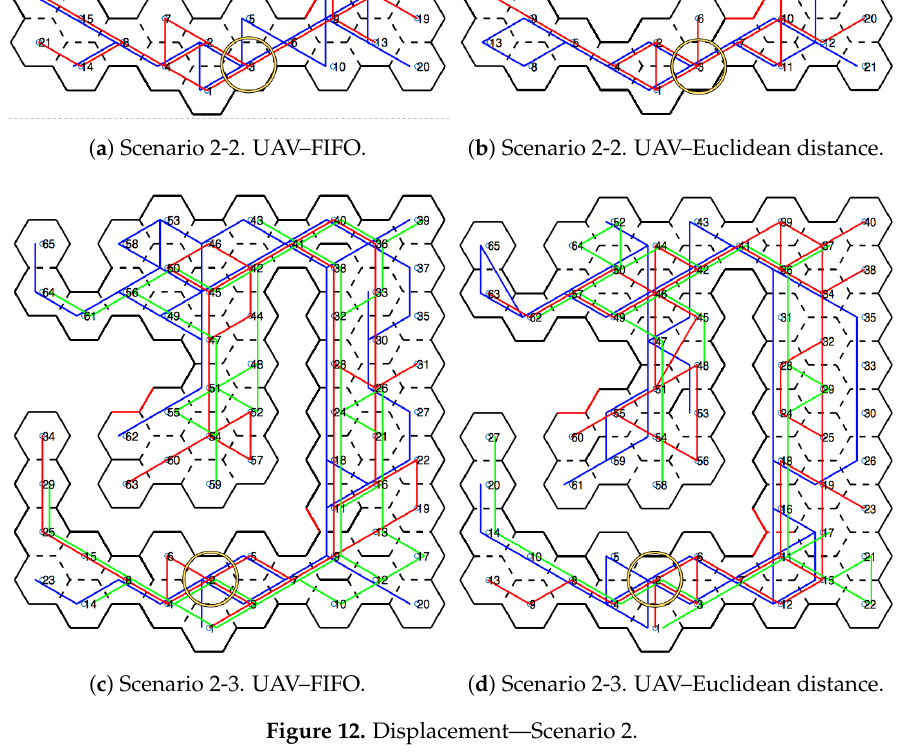
Figure 12. Displacement—Scenario 2.